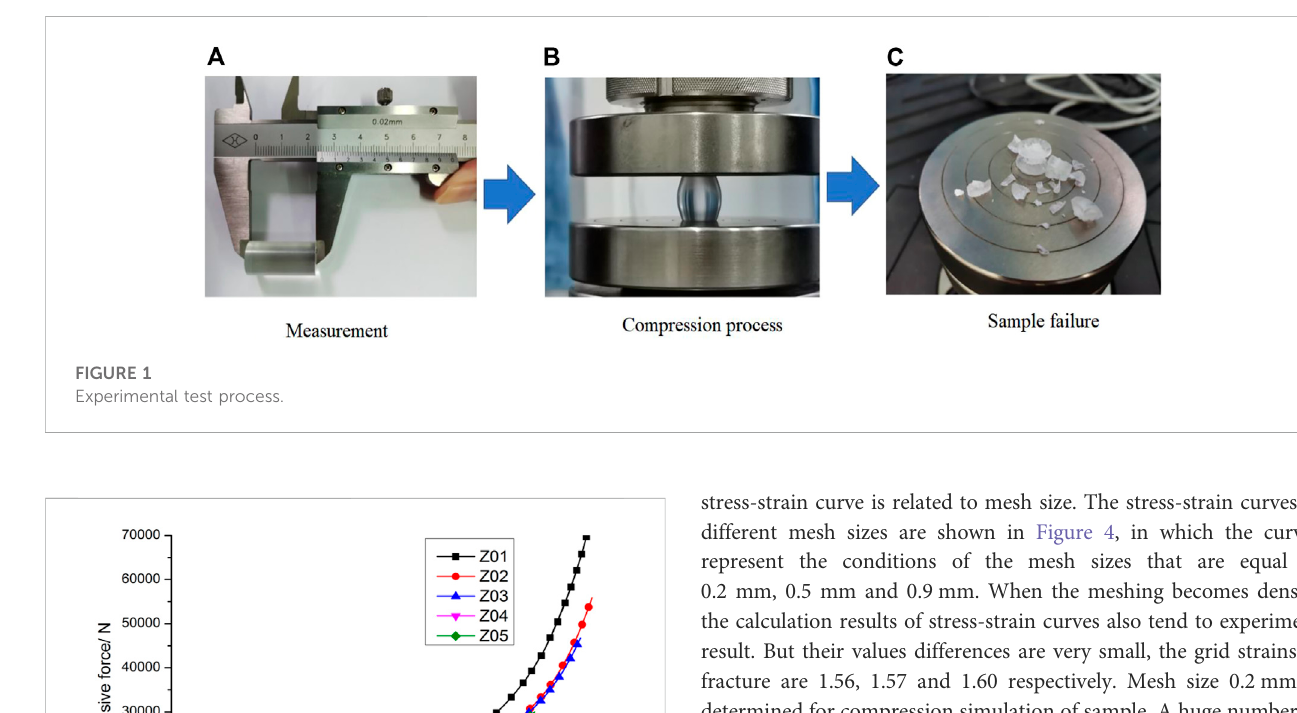
stress-strain curve is related to mesh size. The stress-strain curves at different mesh sizes are shown in Figure 4, in which the curves represent the conditions of the mesh sizes that are equal to 0.2 mm, 0.5 mm and 0.9 mm. When the meshing becomes denser, the calculation results of stress-strain curves also tend to experiment result. But their values differences are very small, the grid strains at fracture are 1.56, 1.57 and 1.60 respectively. Mesh size 0.2 mm is determined for compression simulation of sample. A huge number of elements will lead to a large amount of computer resource requirements. Therefore, mesh size 0.9 mm is determined for simulation of fully-transparent deep-sea pressure hulls.